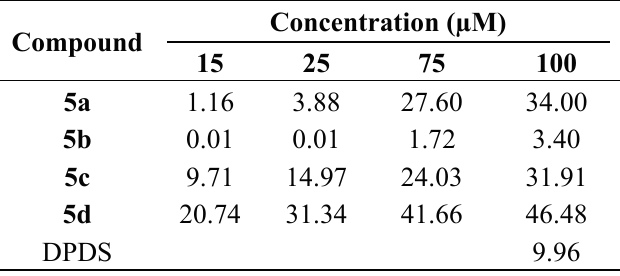
Table 1. Thiol peroxidase like-activity ( Δ /Minutes × 1000) of 2-picolylamide-based diselenides 5